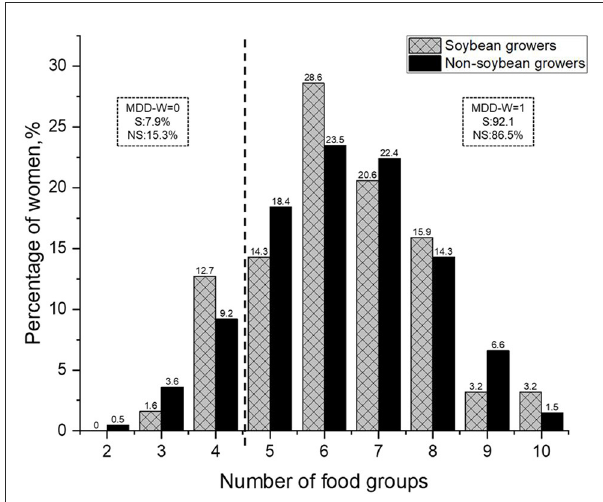
FIGURE2 Percentage of women achieving different women’s dietary diversity scores (WDDS-10) and prevalence of the minimum dietary diversity for women of reproductive age (MDD-W) among soybean (S) and non-soybean farmers (NS). MDD-W = 1 if the women consumed at least five or more different food groups during the past seven days and 0 otherwise. The dotted line denotes a cut-off point for MDD-W. N =